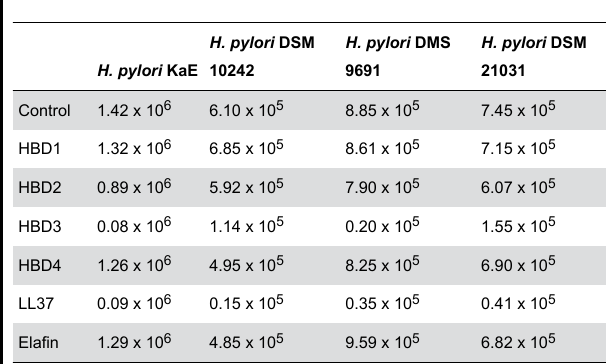
Table 2. Colony forming units (CFU/ml) of H. pylori strains treated with antimicrobial peptides in a concentration of 20 µg/ml (Means of two independent